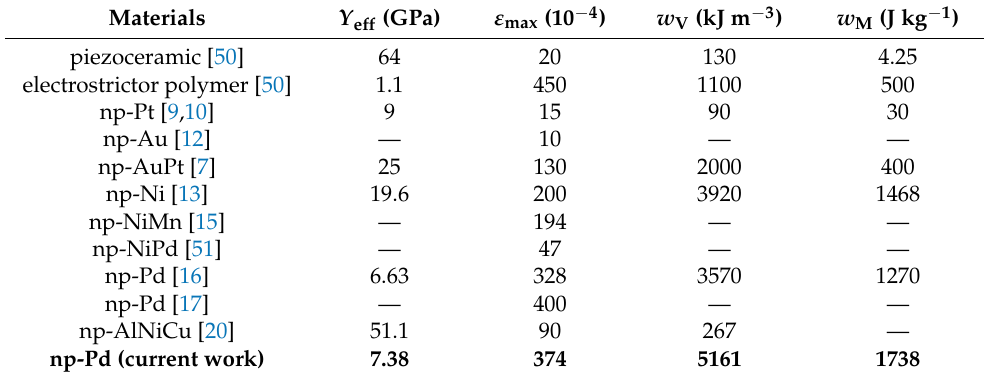
Table 2. Figures of merit for various actuator